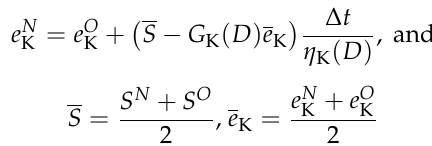
Figure 12. Influence of U 0 and α to strain curve and damage: ( a ) α = 0.03; ( b ) U 0 = 1.33 × 10 6 (Note: K = 10 GPa, G M = 10 GPa, G K = 250 GPa, η M = 10,000 GPa ∙ h and η K = 500 GPa ∙ h).